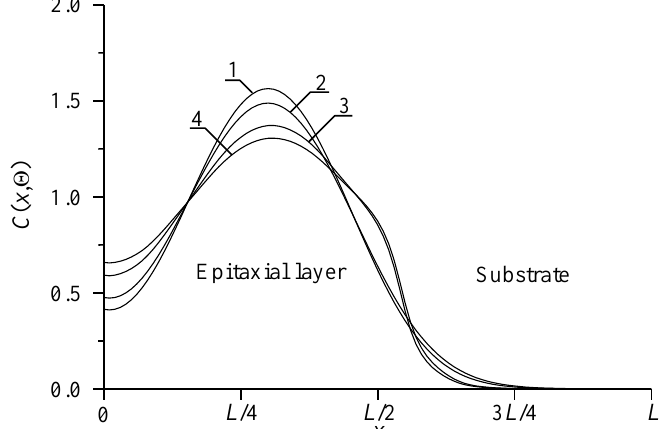
Fig. 3. Distributions of concentration of implanted dopant in heterostructure from Fig. 1 in direction, which is perpendicular to interface between epitaxial layer substrate.